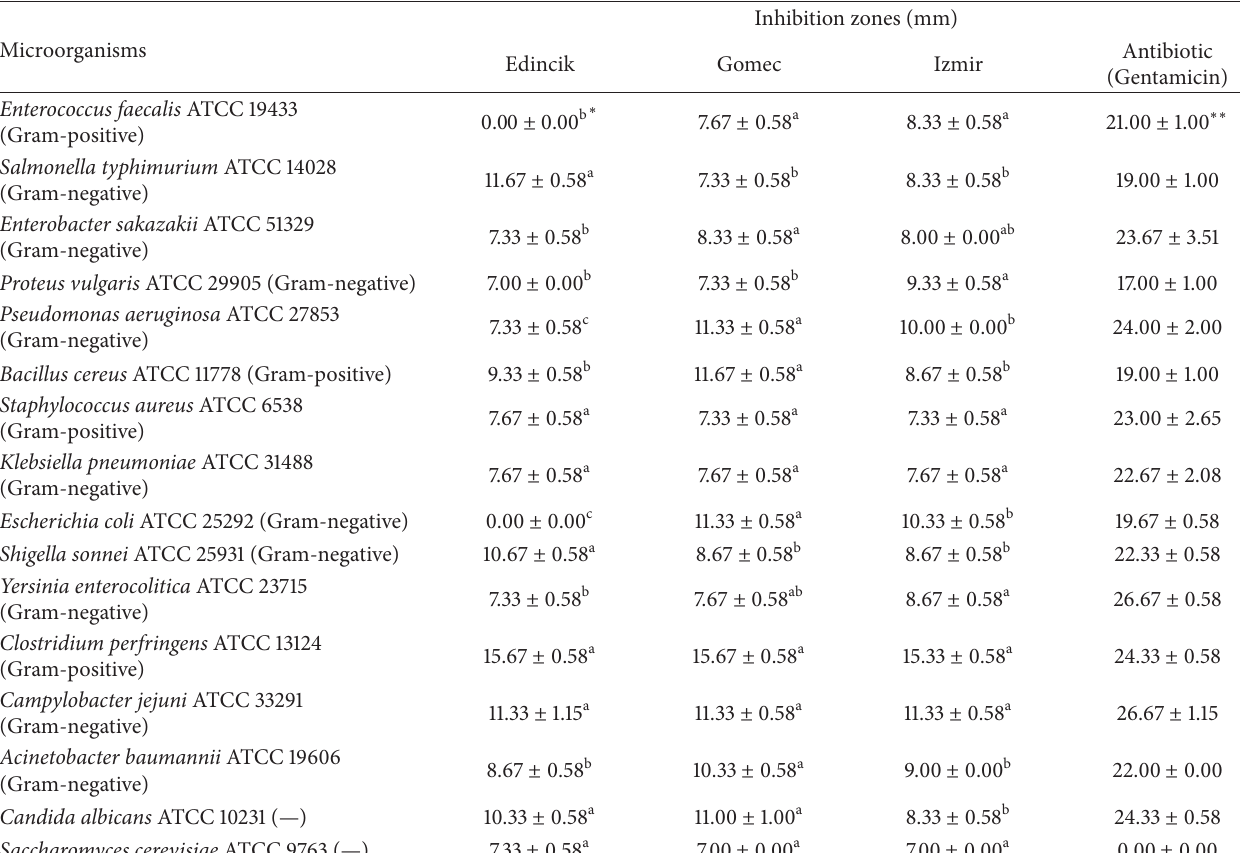
Table 5: Antimicrobial activities of the phenolic extracts of virgin olive oils.